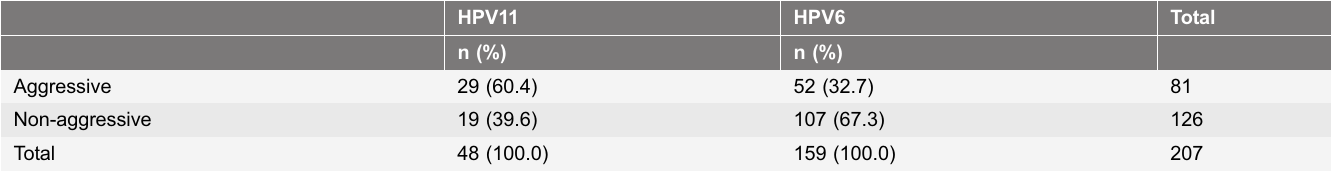
Table 5. Distribution of HPV6 and HPV11 in patients (including AoRRPs and JoRRPs) with an aggressive or non-aggressive clinical course (n 5 207) a . HPV11 HPV6